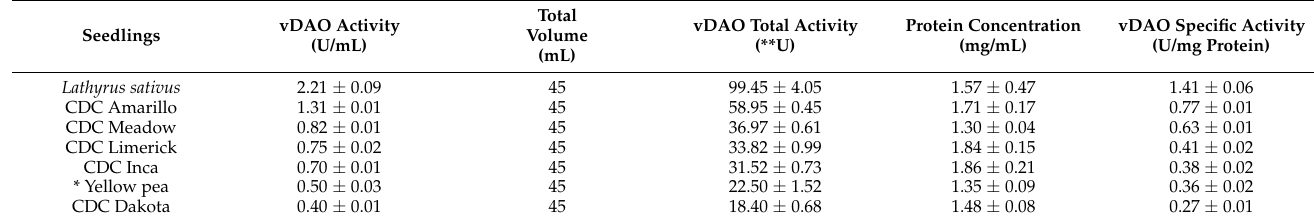
Table 1. DAO activity in seedling extracts of grass pea and